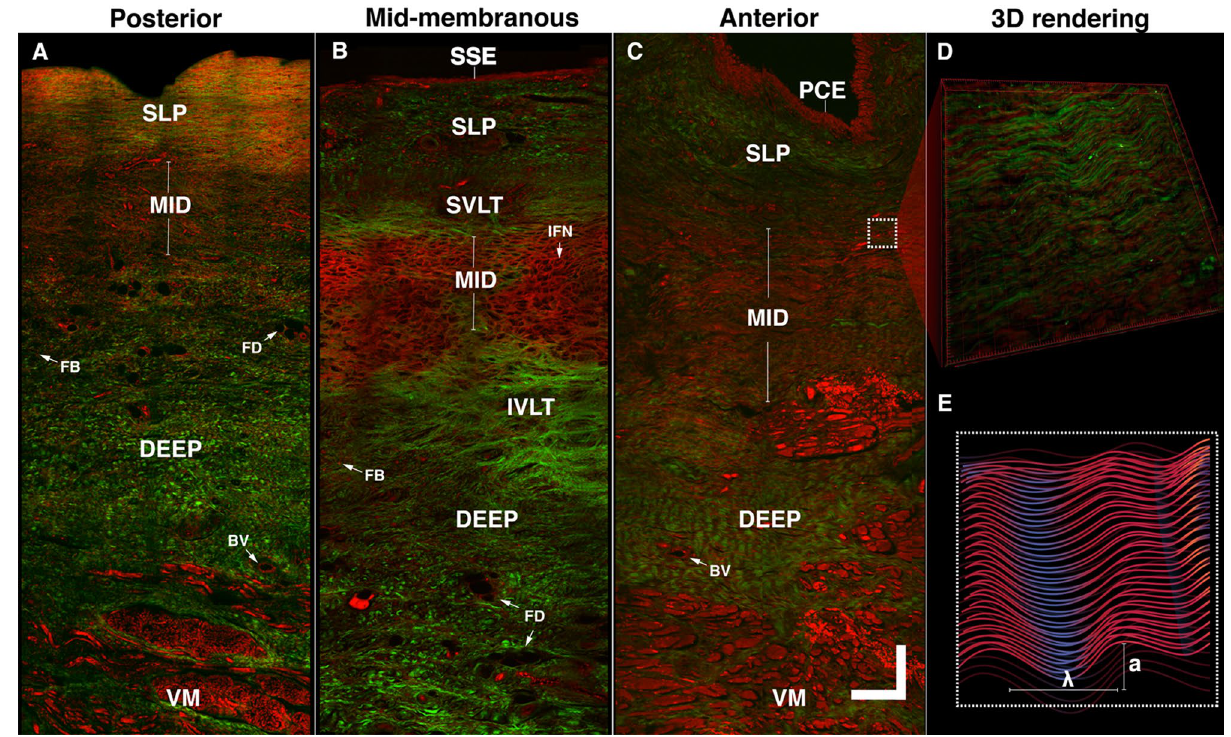
Figure 5. Characterization of the human adult vocal fold using two-photon excitation fluorescence (TPEF) and second harmonic generation (SHG). Composite image showing TPEF (color-coded red) and SHG (color- coded green) of a 50-year-old female vocal fold (VF) imaged with a 920 nm excitation wavelength. The posterior (A) , mid-membranous (B) , and anterior (C) section of the VF shows a different fiber distribution. A delicate intertwined fibrous network (IFN) is visible in the mid-membranous region. The depth and the anteroposterior position dictate the density and maturity of elastic and collagen fibers. The inset shows the 3D rendering of the fiber waviness in the anterior region (D) and fiber waviness schematic (F) . SSE stratified squamous epithelium; PCE pseudostratified ciliated epithelium; SLP superficial lamina propria; MID mid lamina propria; Deep deep lamina propria; IFN intertwined fiber network; SVLT superior vocal ligament transition; IVLT inferior vocal ligament transition; BV blood vessel; FB fibroblasts; FD fat droplets; VM vocalis muscle. Scalebars: 150